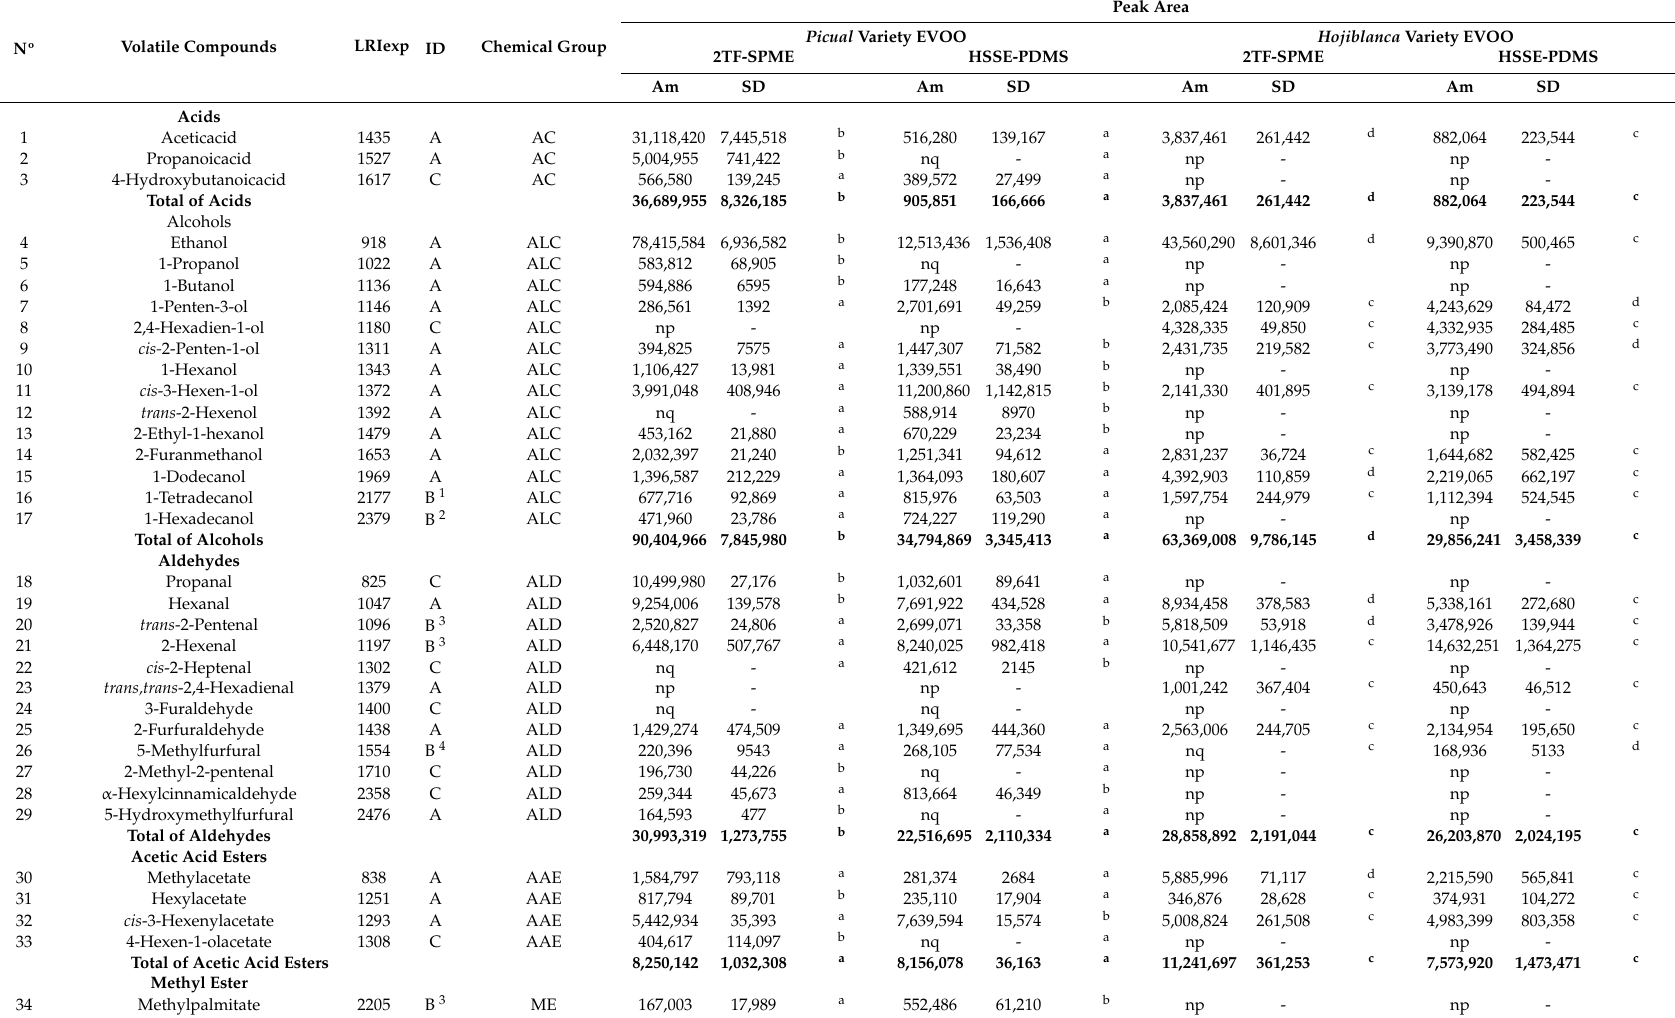
Table 3. Volatile compounds determined in Picual and Hojiblanca varieties of EVOO by di ff erent sampling